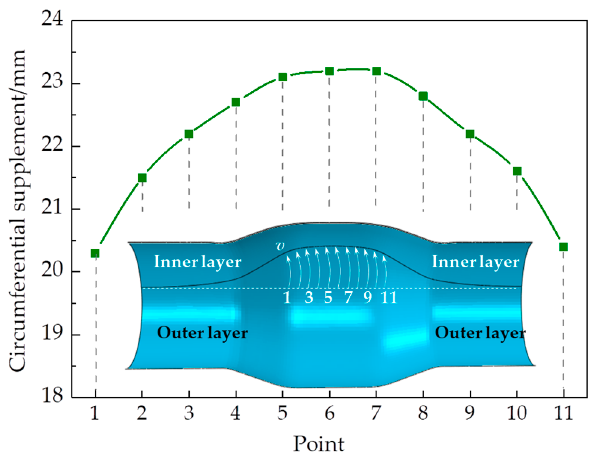
Figure 12. Distribution of circumferential material flow at the edge of the inner layer.